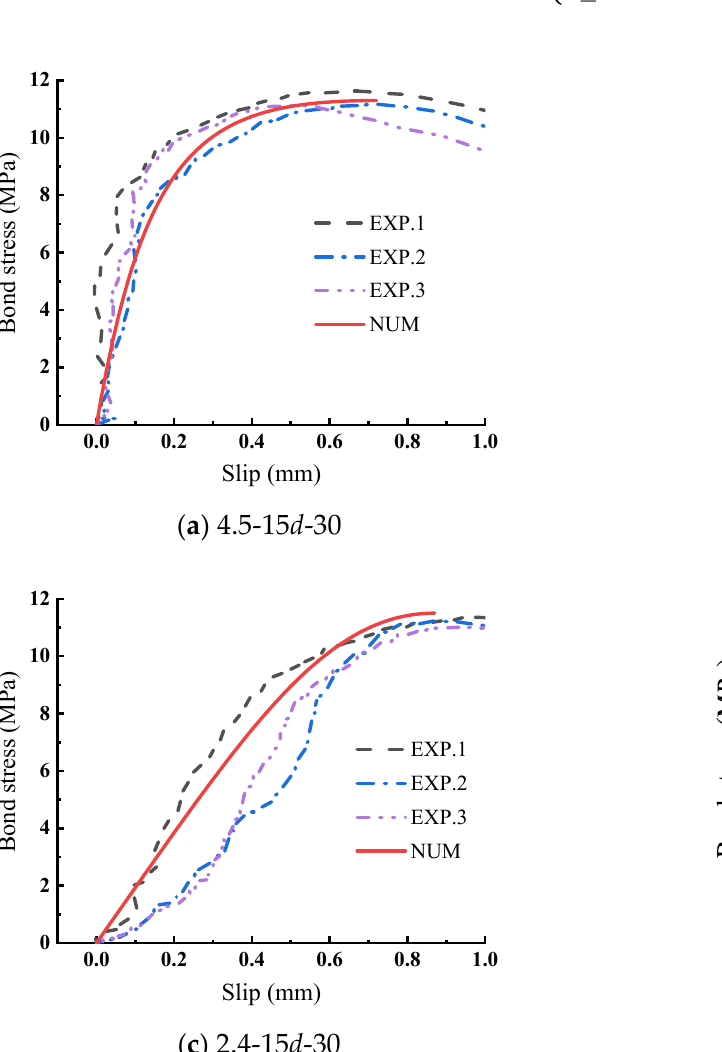
( d ) Summary of comparison curve Figure 8. Comparison between measured and predicted bond slip curves in upward stage. In Equation (5), s a denotes the slip value corresponding to the peak value of bond strength, which is reduced due to part of the tensile stress is transferred to the transverse steel strand in the ECC, and consequently the shear deformation of the ECC becomes smaller. In the upward stage, where no obvious shear failure takes place, the relative slippage between the two materials is reduced due to the presence of transverse steel wires. The formulation of s a could be written as Equation (12):